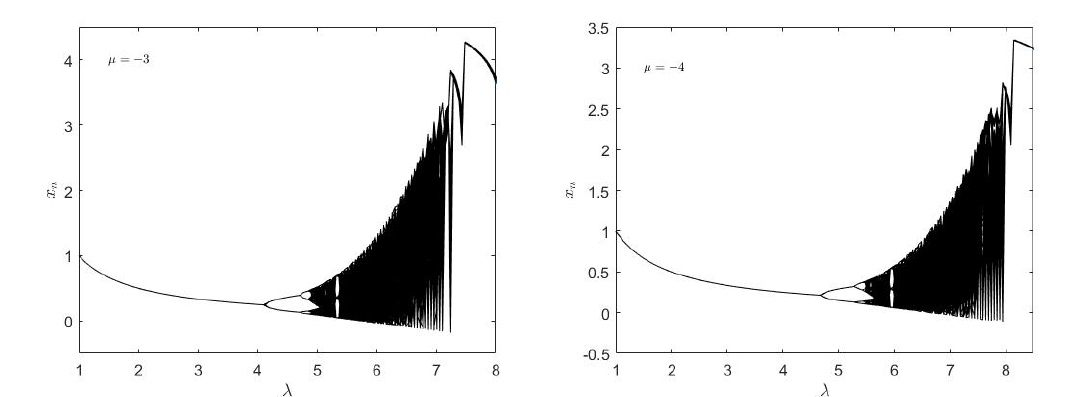
Figure 4. Bifurcation diagram for μ = − 3 Figure 5. Bifurcation diagram for μ = −